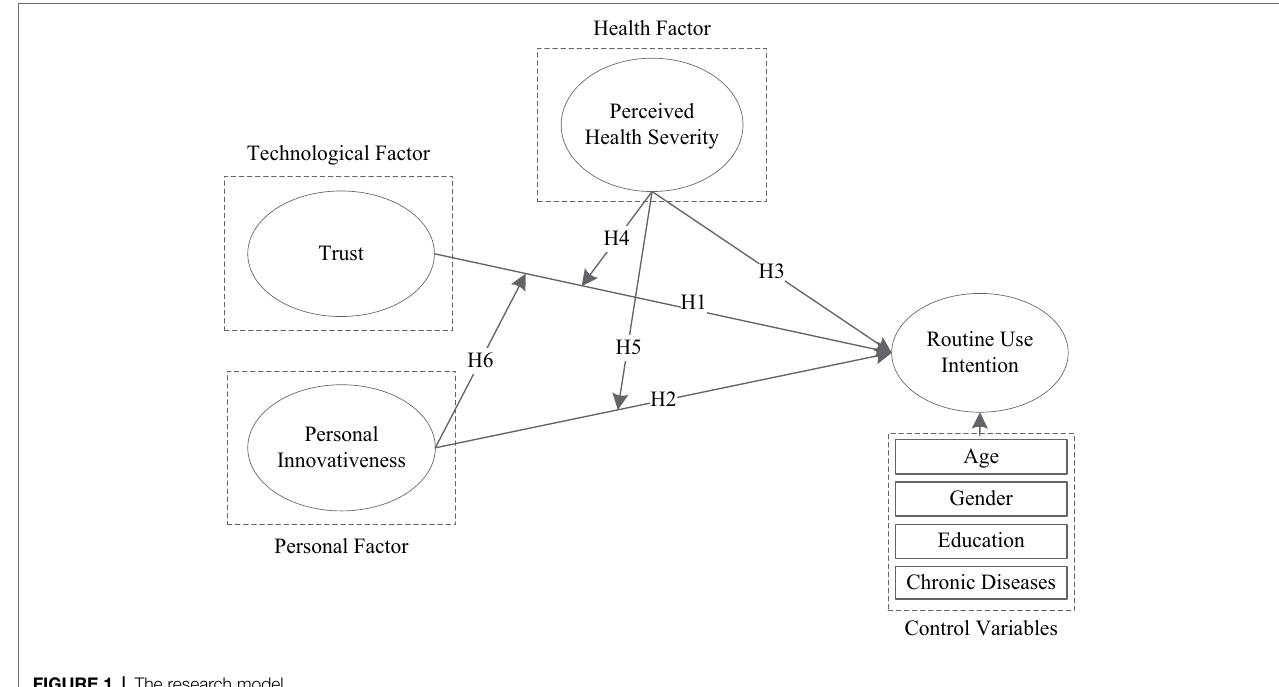
FIGURE 1 | The research